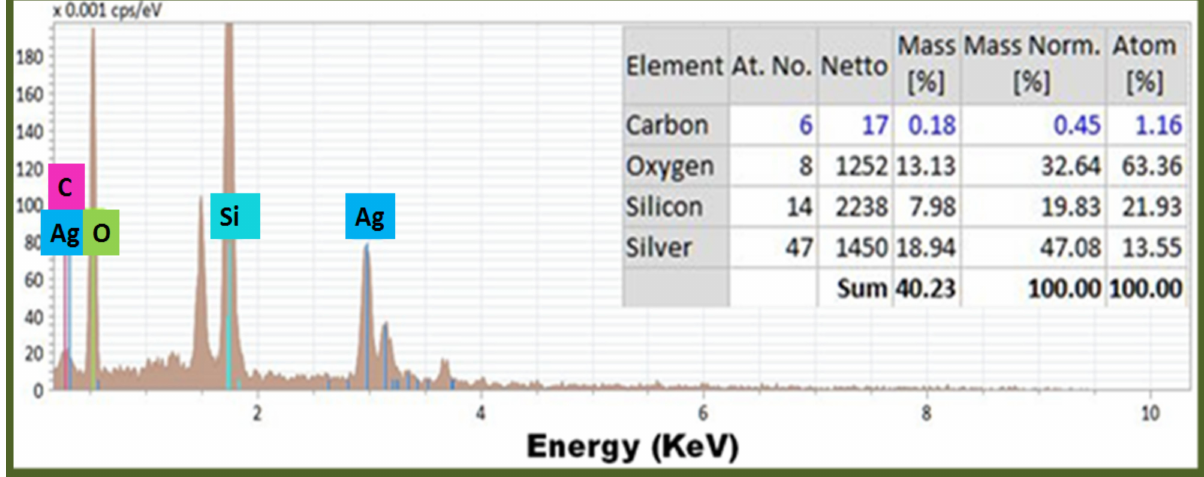
Figure 6. Obtained results of the elemental study of Ag + SiC (5 vol.%) composite